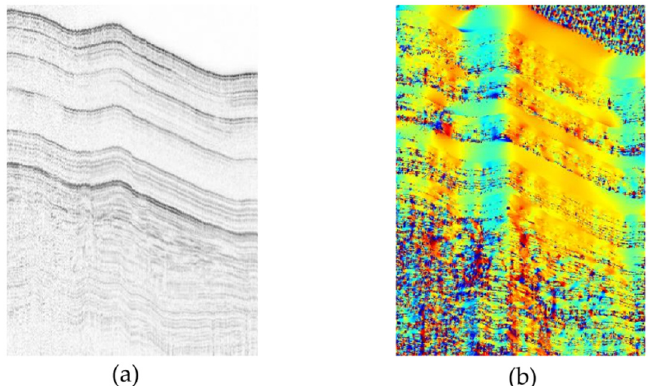
Figure 8. The SBP image after histogram matching and its corresponding direction information, ( a ) is the SBP image after grayscale equalization, and ( b ) shows the direction information.